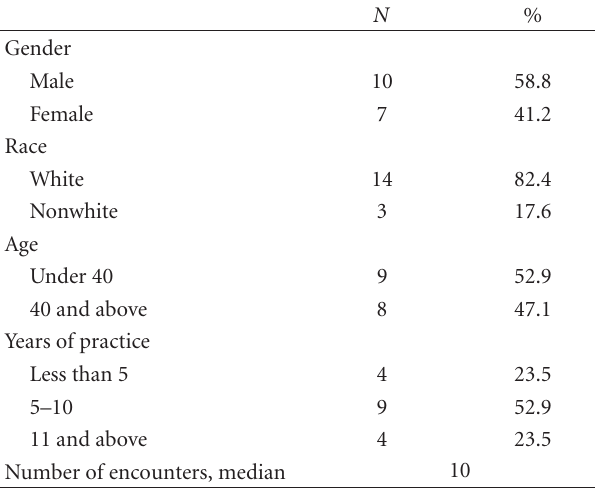
Table 2: Characteristics of the patient sample ( n = 177). Table 3: Characteristics of the physician sample ( n =